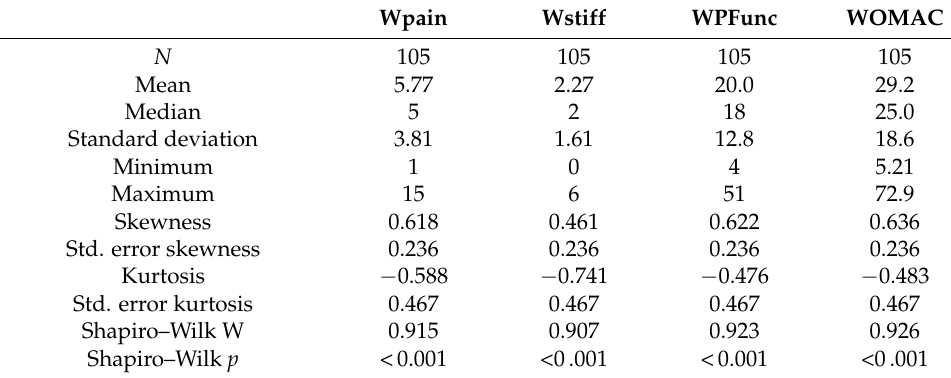
Table 3. WOMAC Knee Functional Scale